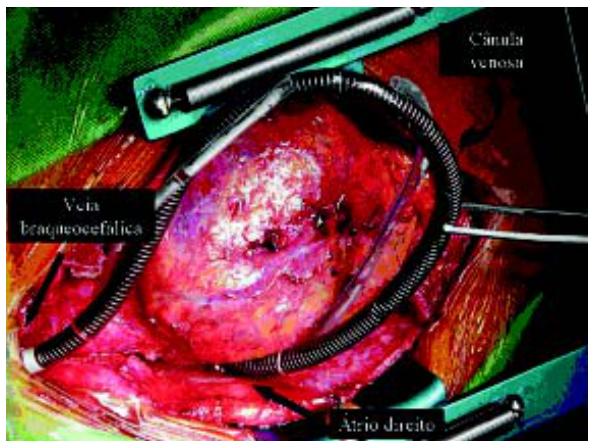
Fig. 1 – Aspecto intra-operatório da derivação venoatrial da veia braquiocefálica para o átrio direito, a qual é utilizada para confecção da operação de Glenn bidirecional sem o auxílio da circulação extracorpórea. Também podem ser observadas as aderências referentes à operação prévia de Blalock-Taussig